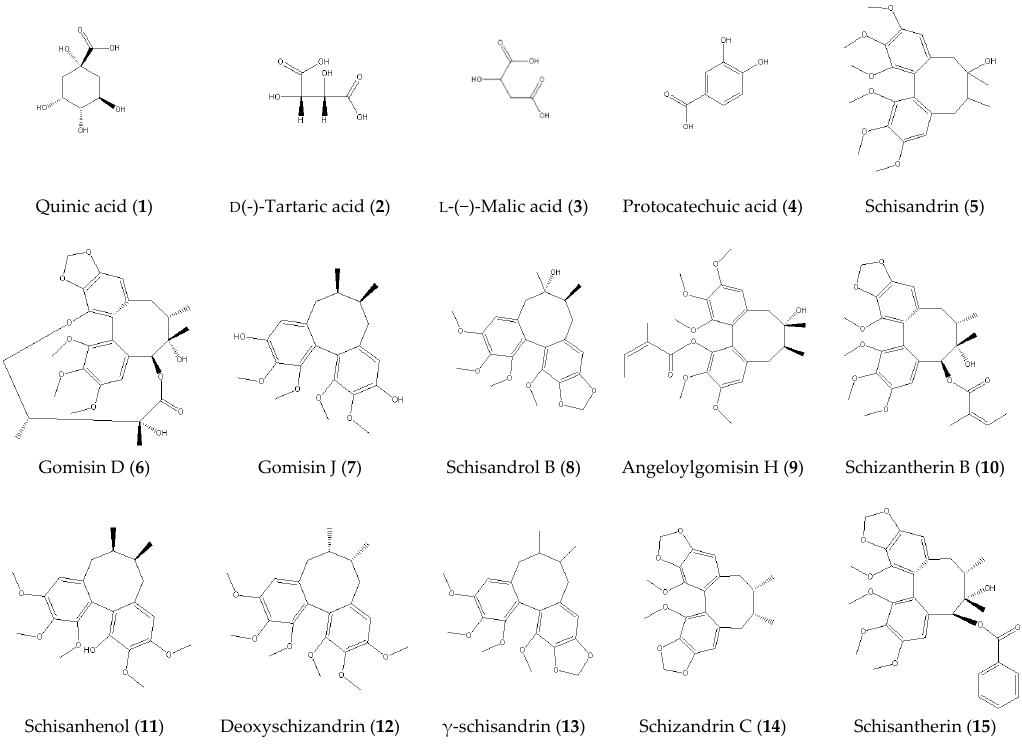
Figure 6. Chemical structures of 15 reference substances.